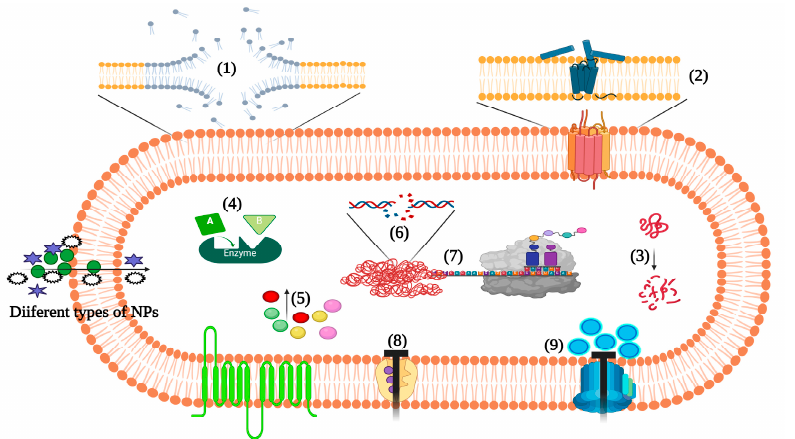
Figure 3. Schematic representation depicting the mechanisms of action of nanoparticles (NPs) with stronger experimental evidence. Metallic and other types of NPs can cause cell membrane disruption (1), membrane (2) and cytoplasmic (3) protein destabilization, inactivation of enzyme and metabolic functions (4), generation of reactive oxygen species (5), damage to DNA (6) and ribosomal (7) assemblies, and impairment of the transmembrane electron transport system (8) and efflux pumps (9).